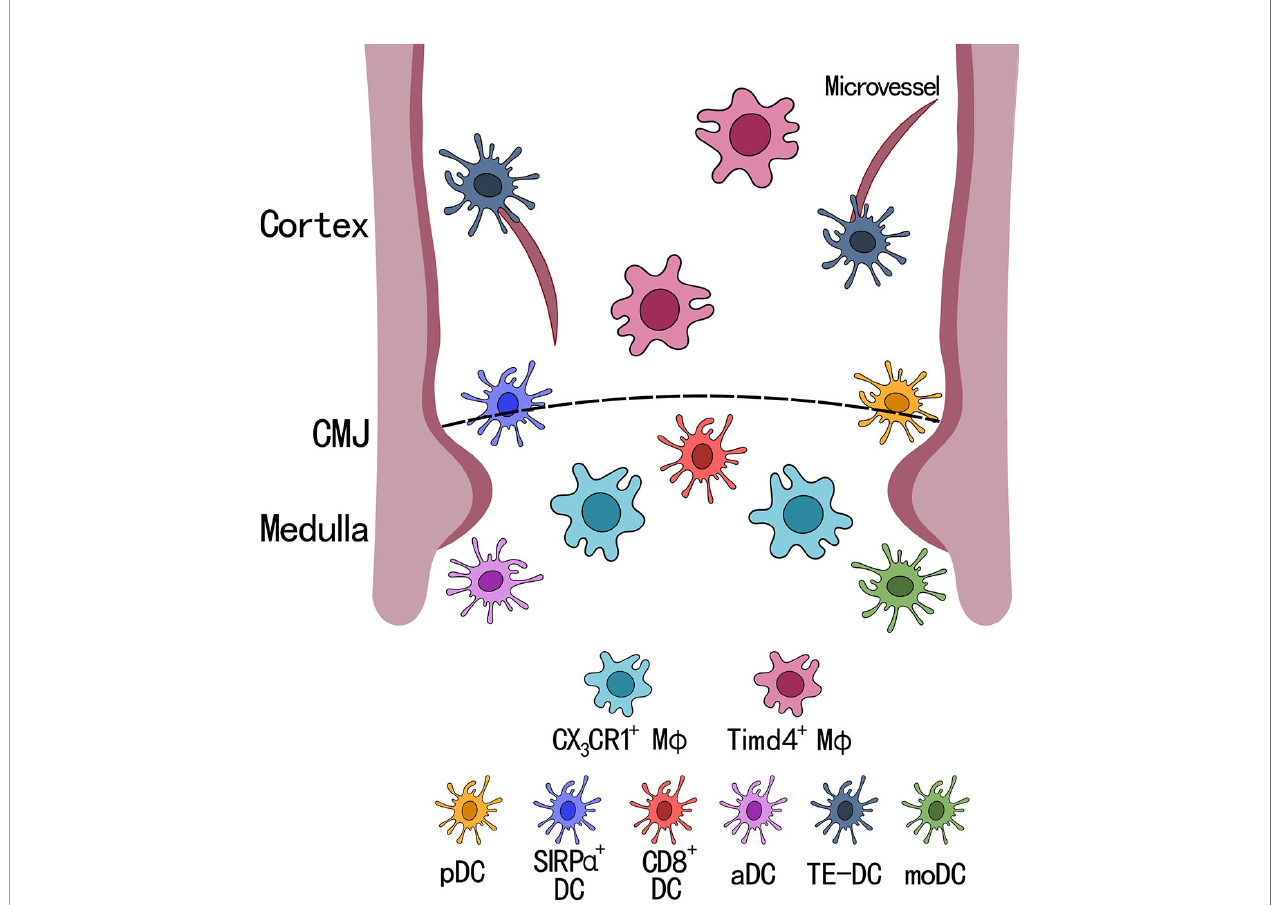
FIGURE 2 | Localization of dendritic cell and macrophage subsets in the thymus. There are 6 subsets of dendritic cells (DCs) and 2 subsets of macrophage (M Ф ) in the thymus. SIRP a + DCs and pDCs are located closely to the cortical-medullary junction (CMJ), CD8 + DCs, activated DCs (aDCs), and CD14 + SIRP a + moDCs (moDCs) are located within the medullary region, and transendothelial DCs (TE-DCs) are located between the microvessels in the thymus. Timd4 + macrophages are located within the cortex and uniquely express Spic and Vcam1 , while CX 3 CR1 + macrophages are located at the CMJ expressing Runx3 and antigen presenting genes, such as H2-Q7